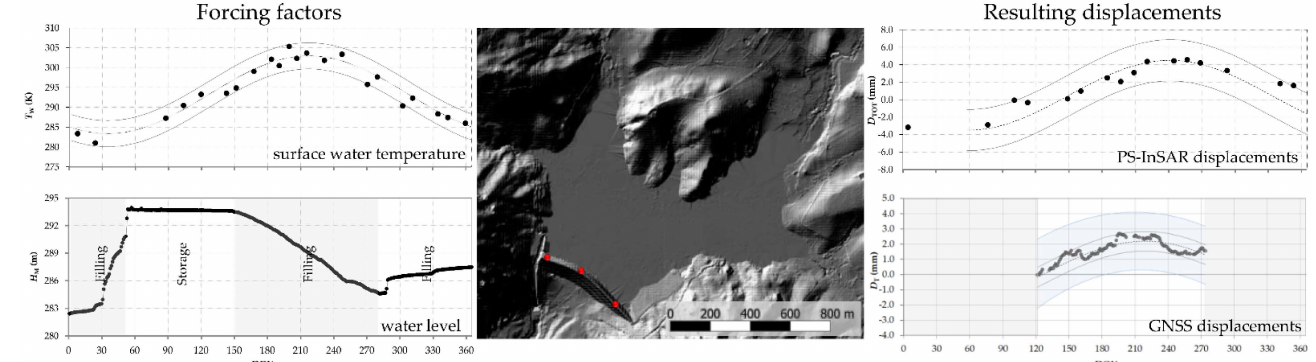
Figure 11. Comprehensive dam monitoring with on-site and remote-retrieved forcing factors and resulting displacements [79]. Top left: Daily water levels measured in situ, H IS (m a.s.l.). A linear interpolation curve is superimposed–imposed (continuous line); Up left: the temporal behavior of the water surface temperature, T W (K), retrieved by Landsat 8 data, using both 189-034 and 190-034 scenes. A sinusoidal interpolation curve (continuous dashed line) and a confidence band of ± 2 × σ XY between measured and interpolated values (dark grey lines) are reported to facilitate the interpretation of the phenomenon. Center: hill shade of the dam–reservoir system derived from a digital surface model by setting azimuth and elevation of the incident light at 315 and 45 degrees, respectively). Superimposed the positions of the GNSS stations (red points). Top right: the temporal behavior (DOY in x-axis) of the horizontal total displacements orthogonal to the dam (D TOT , mm) is estimated via PS–InSAR (red dots). A sinusoidal interpolation curve (continuous dashed line) and a confidence band of ± 2 × σ XY between measured and interpolated values (dark grey). Up right: the temporal behavior (DOY in x-axis) of the horizontal total displacements orthogonal to the dam (D TOT , mm) is estimated via Global Navigation Satellite System (GNSS) (grey dots). A sinusoidal interpolation curve and confidence band of ± 2 × σ XY between measured and interpolated values (dark grey lines) were reported to facilitate the interpretation of the phenomenon (continuous line). The interpolation curves at the 10th and 90th percentiles of the raw data were reported (pale blue band) as a measure of its